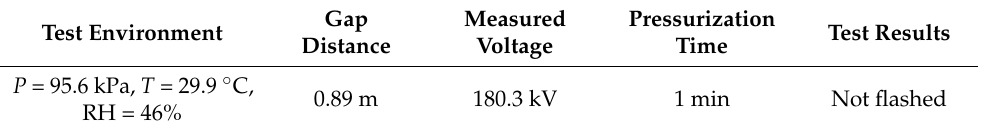
Table 4. Data of the power frequency resistance voltage test.